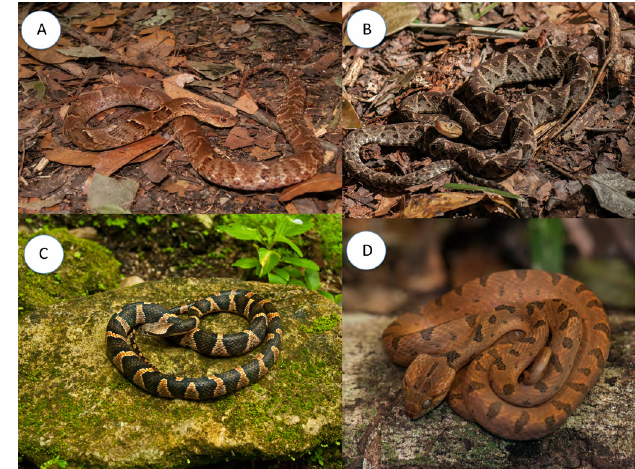
Figure 8. Snakes encountered in the Calakmul Biosphere Reserve: ( A ) Xenodon rhabdocephalis, ( B ) Bothrops asper, ( C ) Leptodeira frenata, ( D ) Leptodeira septentrionalis. Photos by